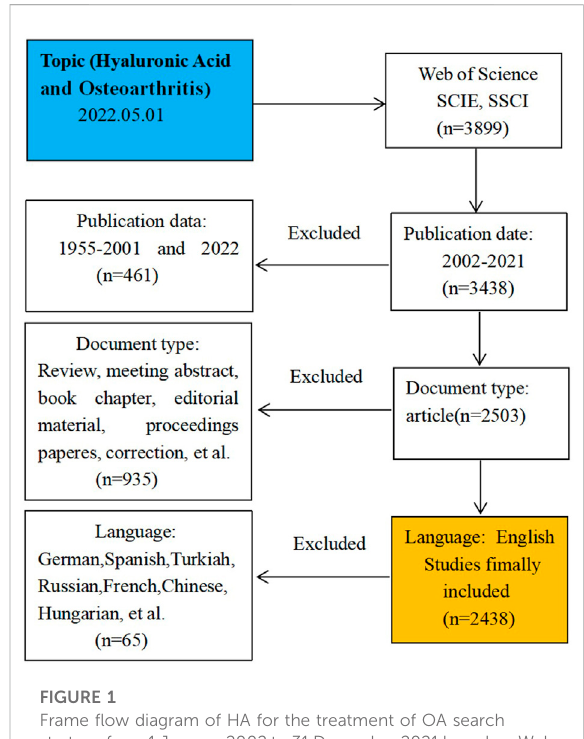
FIGURE 1 Frame fl ow diagram of HA for the treatment of OA